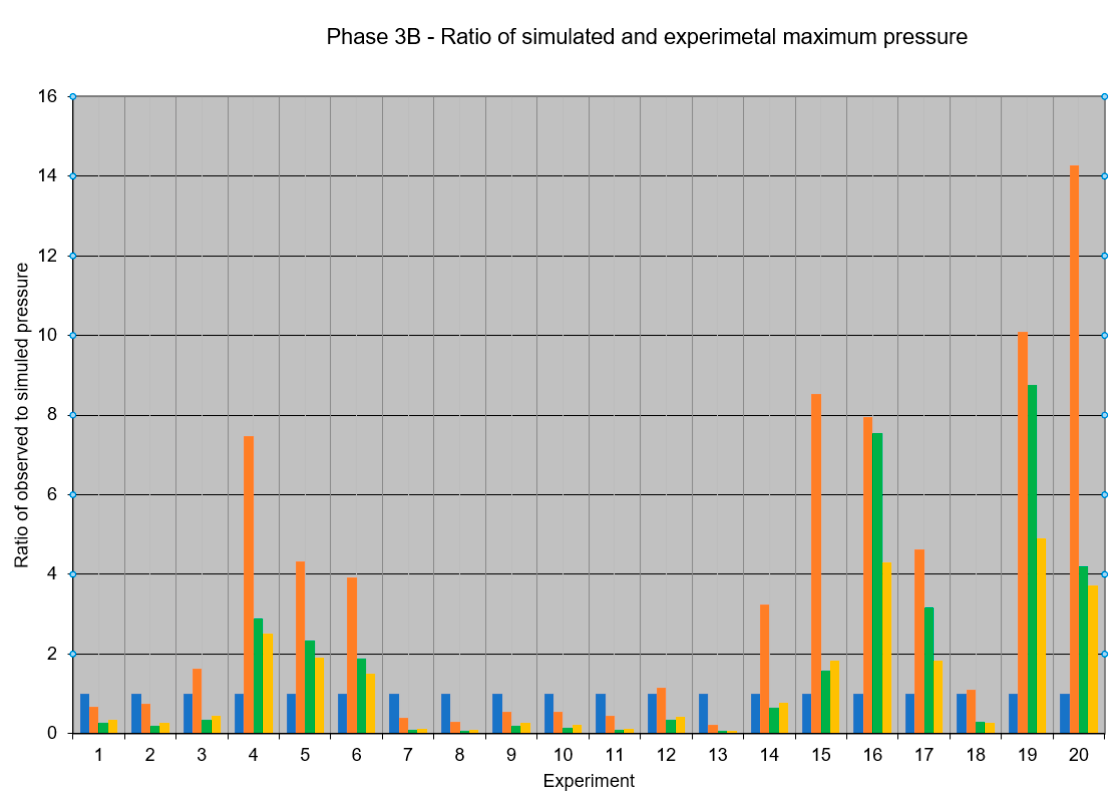
Figure 5. ( top ): A figure showing a comparison of calculated maximum overpressure with measurement (reproduced from [3], and Figure 5 ( bottom ): the comparison of various ESC models against data (by the author) showing the ratio of model prediction with measured values. The number on the x -axis represents the test number in the experiment. The blue bar in the bottom figure is a reference showing the perfect agreement position of 1. Each colour refers to one ESC model; the exact ESC model is not important here. Both of these figures are confusing for the purpose of comparing model performance. The purpose of showing these two figures is to illustrate the difficulties in extracting overall biases and variance for various models.